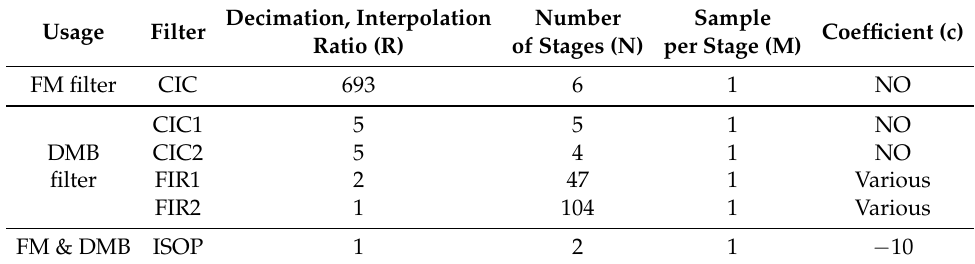
Table 7. Parameter list used for FM and DMB signal